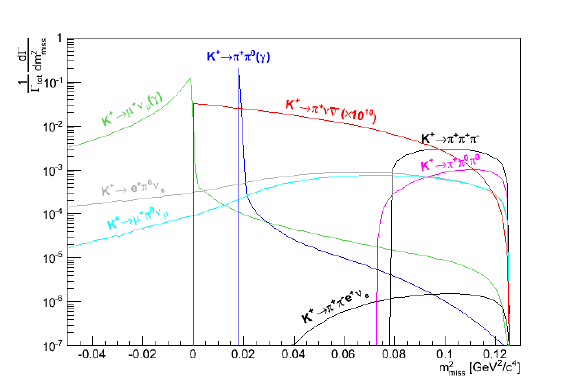
Figure 2. m 2 in the π + mass hypothesis for the positive particle miss for signal and other K + decays.